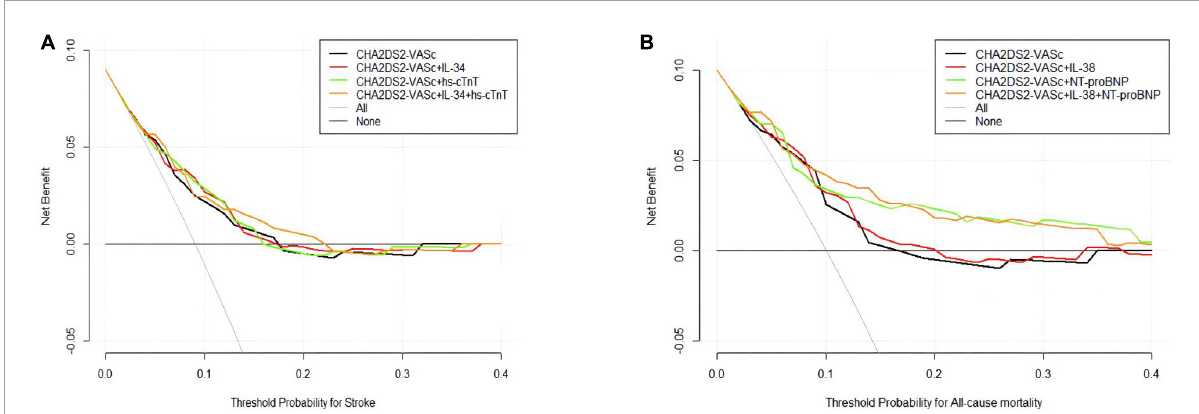
FIGURE1 Decision curve analysis (DCA) of the original and modified CHA 2 DS 2 -VASc score. (A) Stroke model added hs-cTnT and/or IL-34; (B) all-cause mortality model added IL-38 and/or NT-proBNP. The black lines (original scores) and other lines (modified scores) represent the net benefit of each model graphically. The horizontal axis represents the threshold probability of the target adverse event risk. The longitudinal axis shows the net benefit. ILs, interleukins; NT-proBNP, N-terminal fragment B-type natriuretic peptide; hs-cTnT, high-sensitivity cardiac